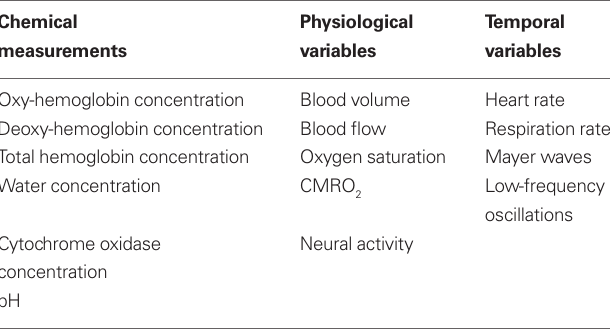
Table 1 | Physiological variables that can be estimated using NIN.